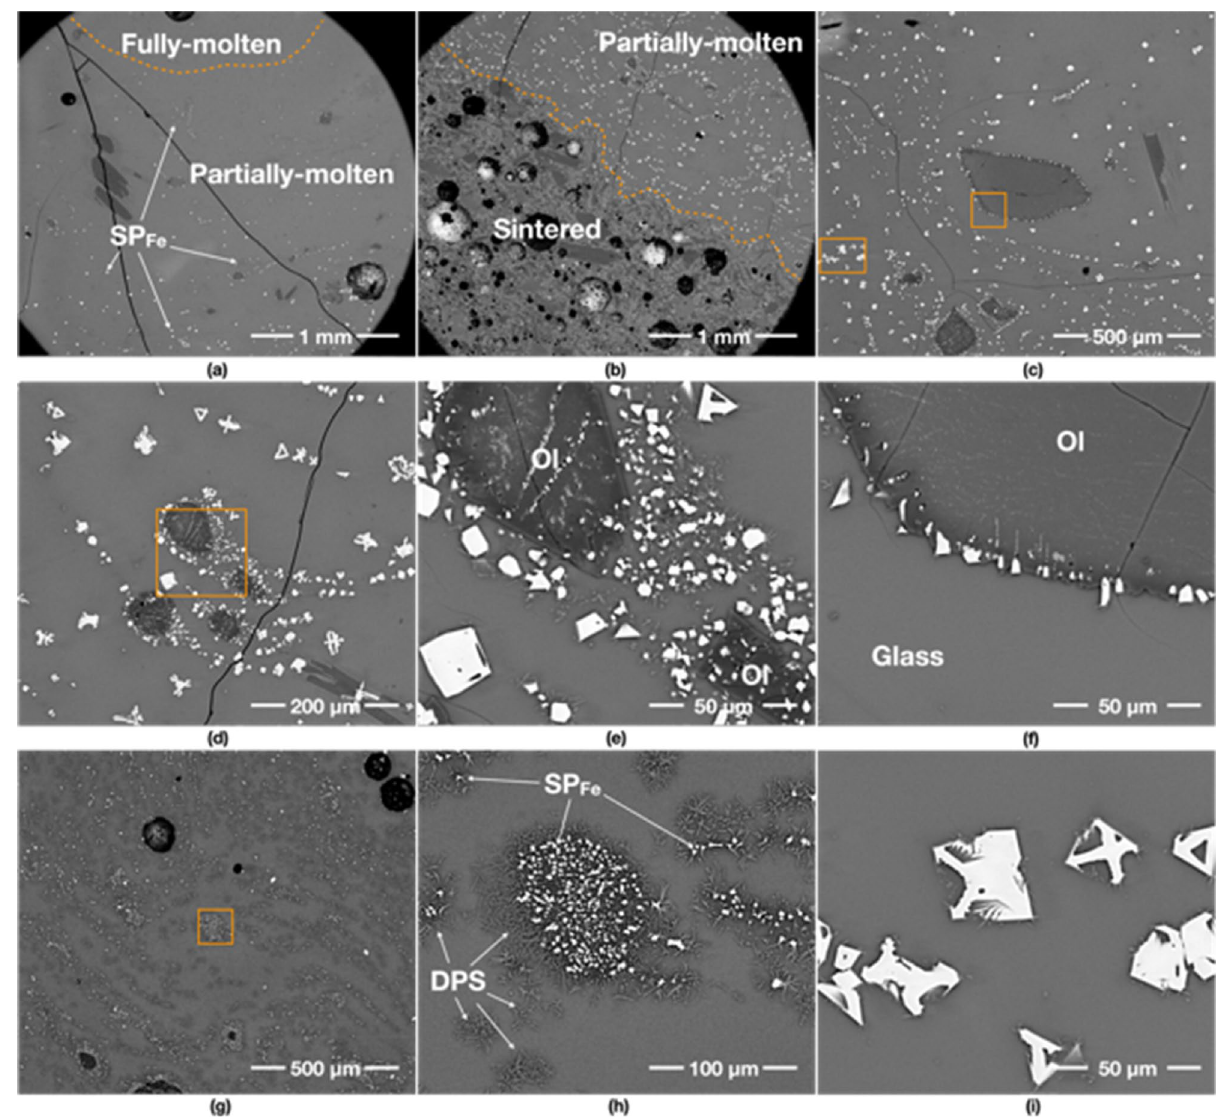
areas. The partially-molten areas in ( a , b ) have abundant SP Fe particles with much fewer dendritic patterned silicates (DPS) than 400 W specimen over the entire area. ( e ) is the detail of the box in ( d ) showing the formed SP Fe particles from an olivine (Ol) grain and the surrounding glass. ( h ) is the detail of the box in ( g ) representing the SP Fe particles formed at the centre of DPS, which are possibly created through the neo-crystallisation of glass reacting with olivine (Ol) grains. ( f ) is the detail of the middlebox in ( c ) indicating the exsolving trace of SP Fe particles from olivine (Ol) grain. ( i ) is the detail of the left box in ( c ) depicting the skeletal growth morphologies of SP Fe classified as a cruciform